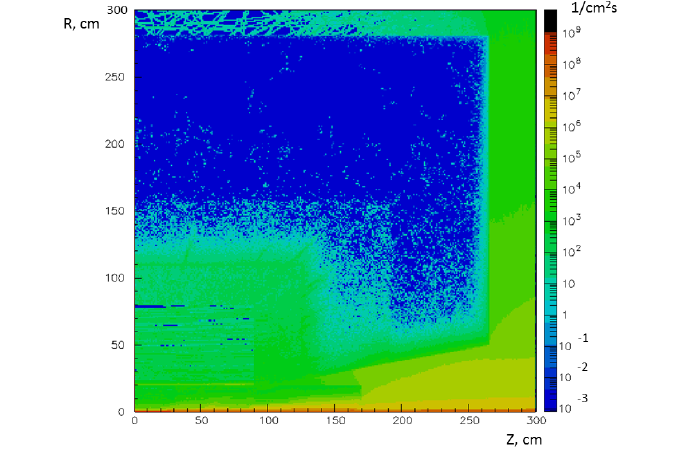
Figure 3. Fluence of electrons and positrons.